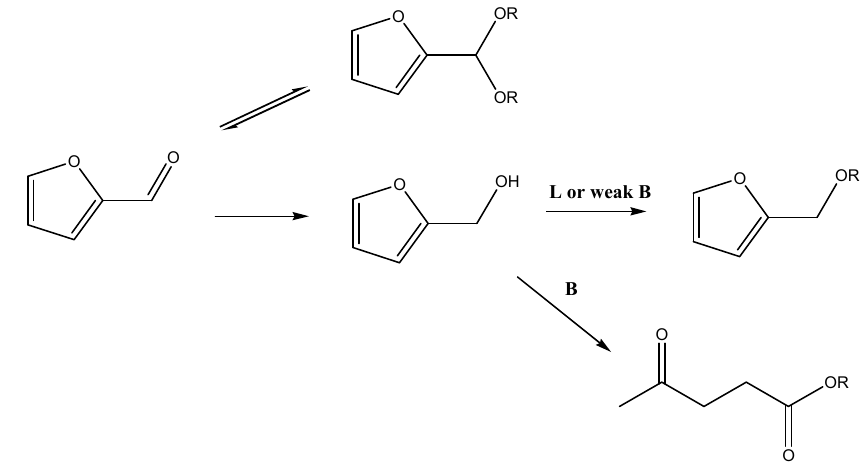
Scheme 10 . Possible products obtained in the reductive etherification of furfural. Scheme 10. Possible products obtained in the reductive etherification of